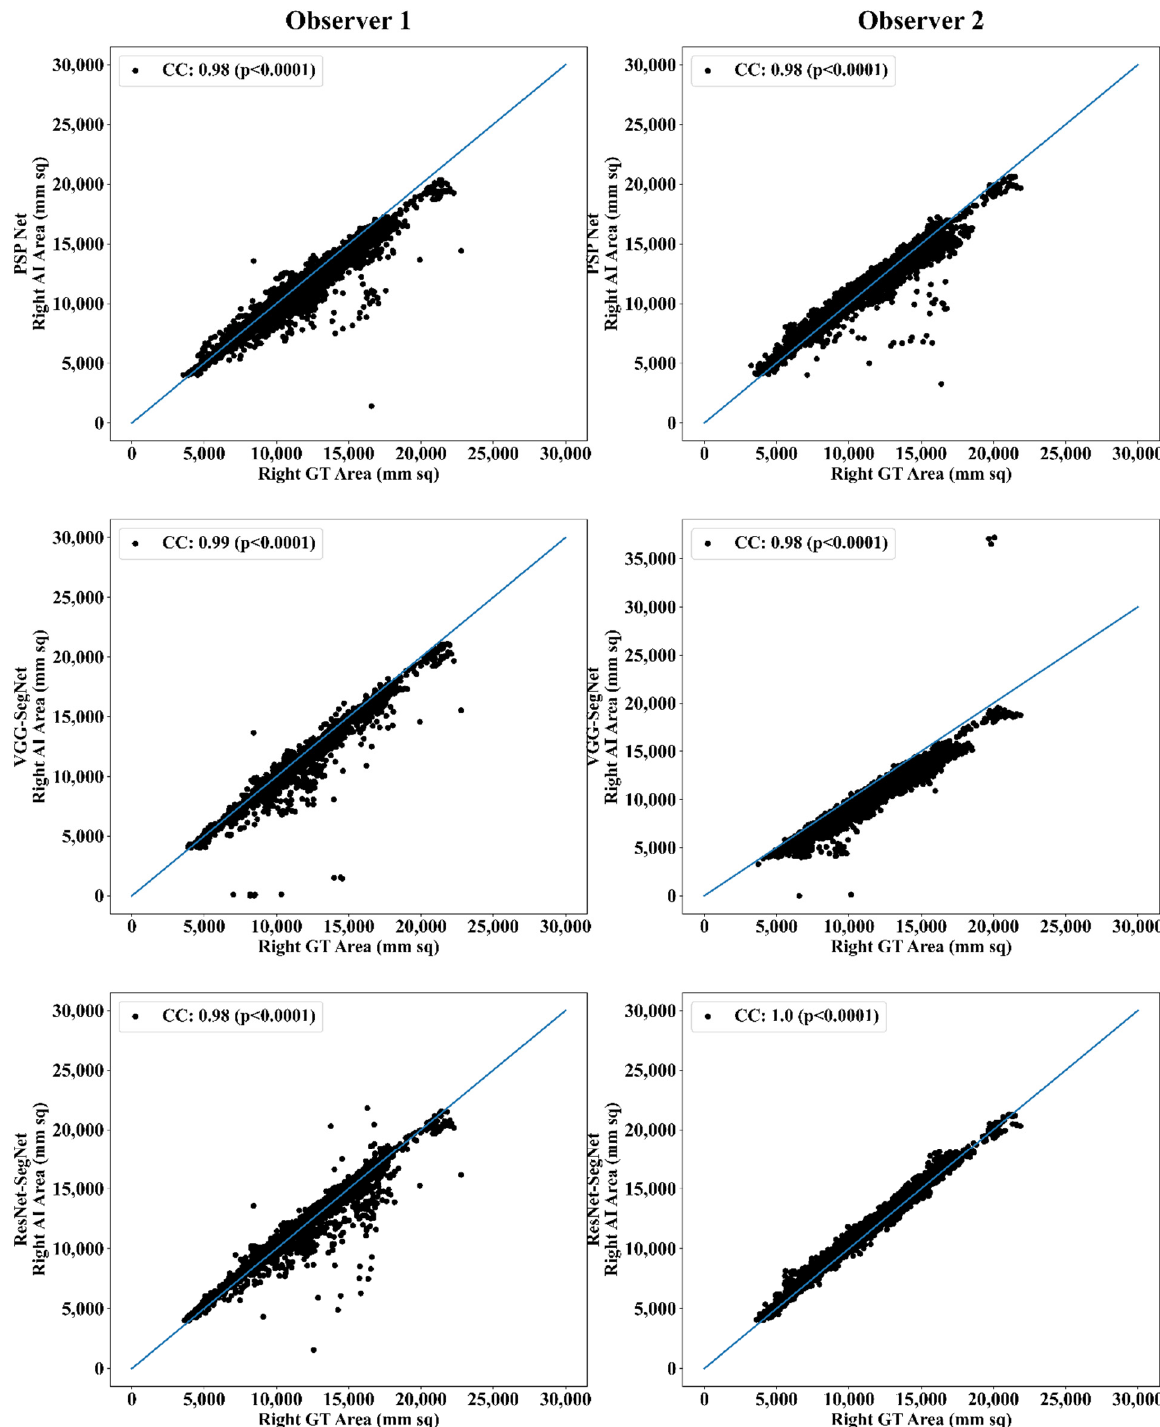
Figure 15. CC of right lung area using three AI models: Observer 1 vs. Observer 2.